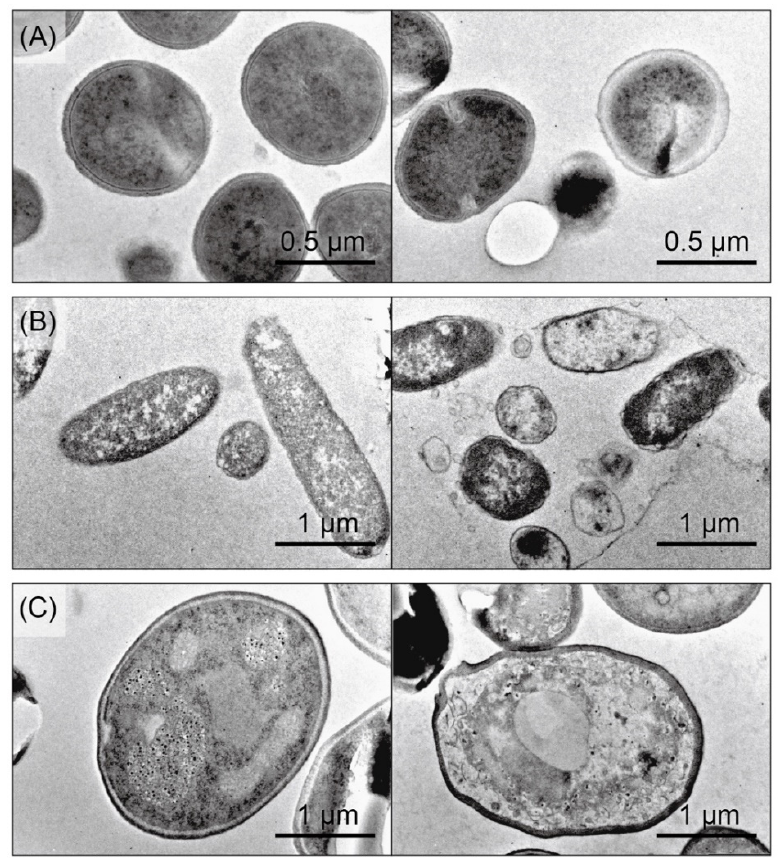
Figure 5. Transmission electron microscope images of S. aureus ( A ), E. coli ( B ), and C. albicans ( C ) cells. The microorganisms are shown in the absence (left panel) and presence (right panel) of 61.3 µM CKR12-PLGA.